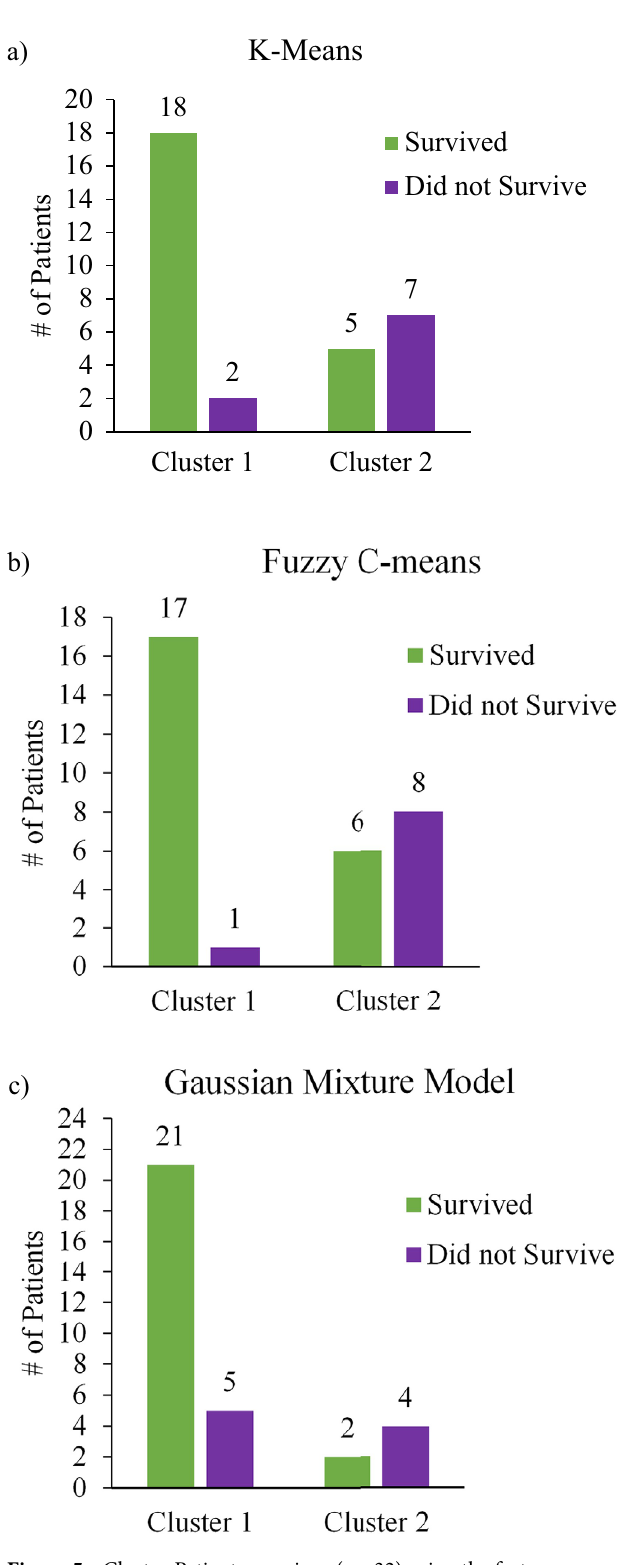
Figure 5. Cluster-Patient groupings (n = 32) using the features-averaged approach as determined by the three unsupervised clustering model. ( a ) K-means; ( b ) Fuzzy C-means; ( c ) Gaussian Mixture model. Green represents patients which survived after 5-years (n = 23) whereas purple denotes patients which did not (n = 9). Of note is the composition of Cluster 1 across all models, being primarily comprised of 5-year survivors (for details, see